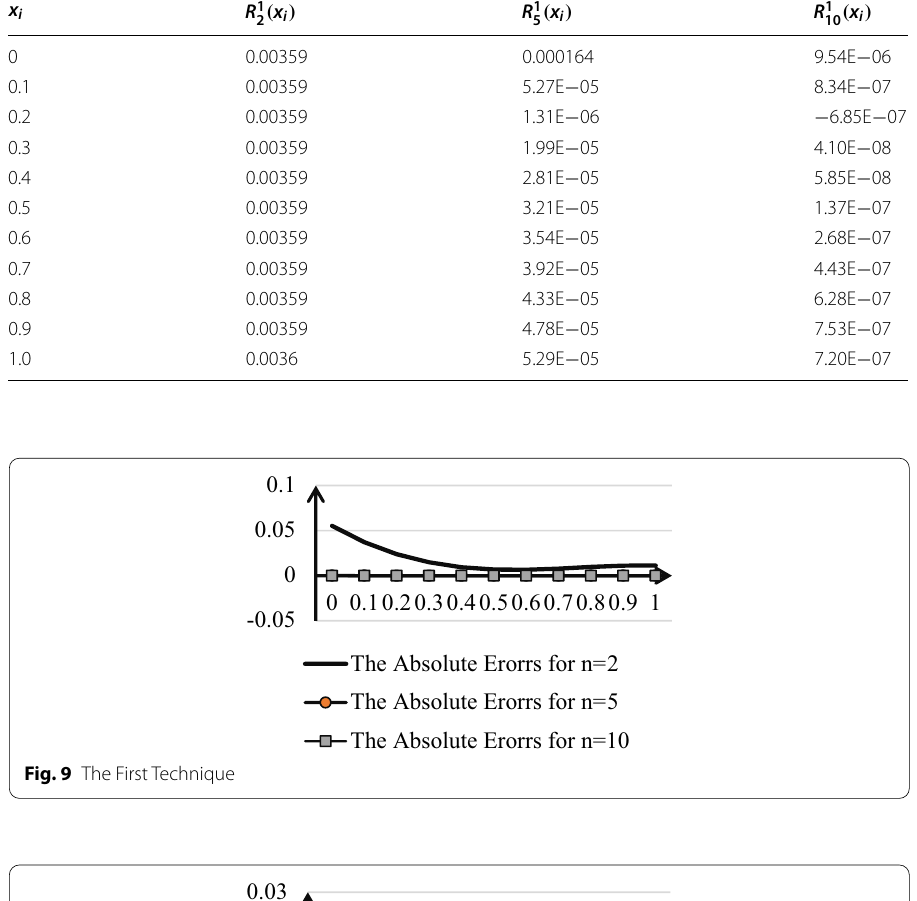
Table 9 The absolute errors R 1 n ( x i ) for n = 2, 5,10 x